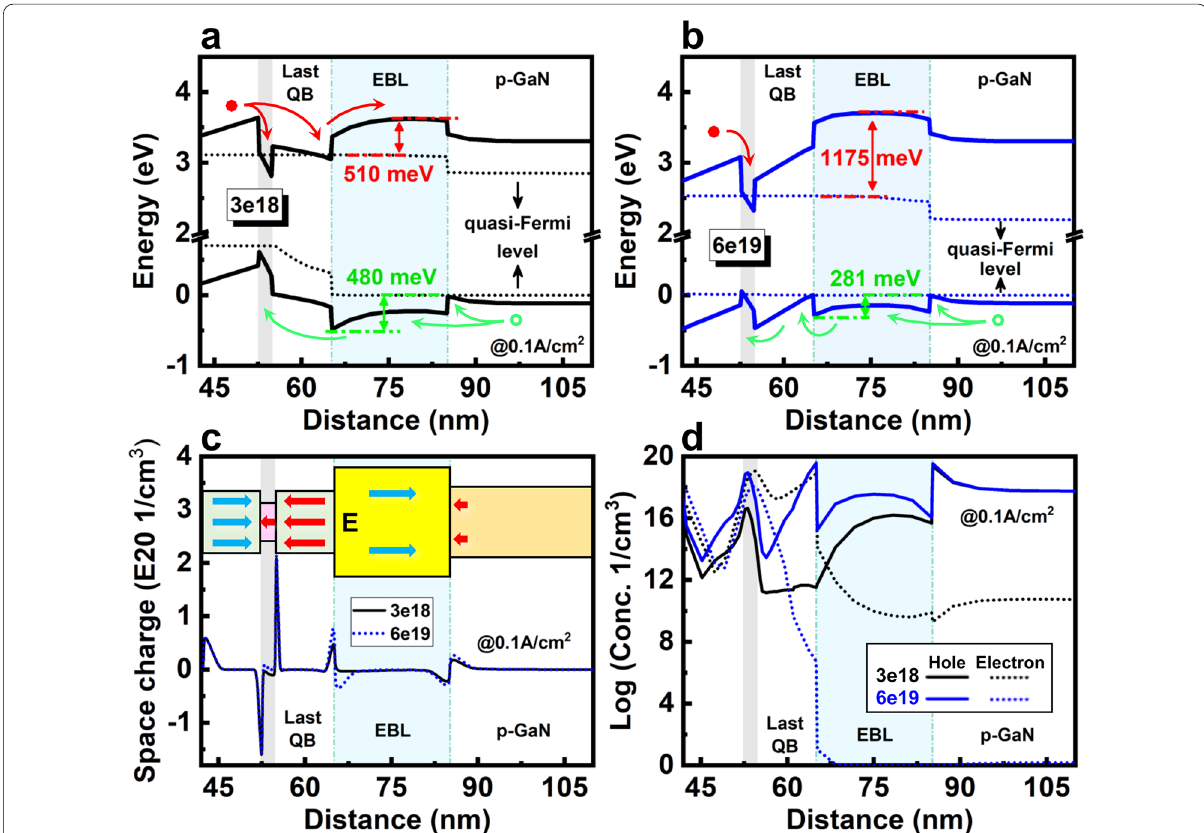
Fig. 7 Energy band diagrams of 2QWs LED with a 3 and d carrier concentration distribution of 2QWs LED with 3 direction of polarization